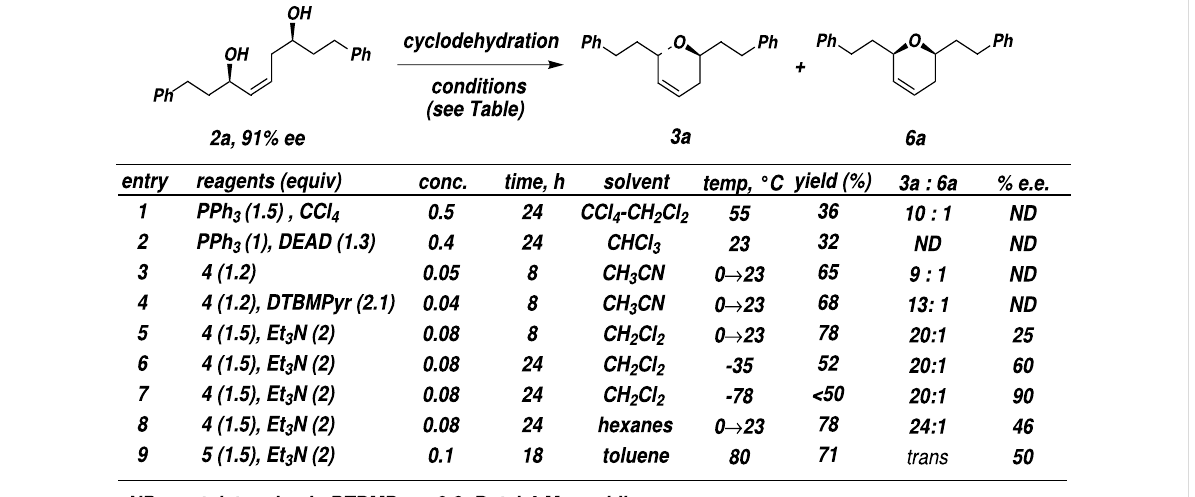
Figure 1: Cyclodehydration of diol